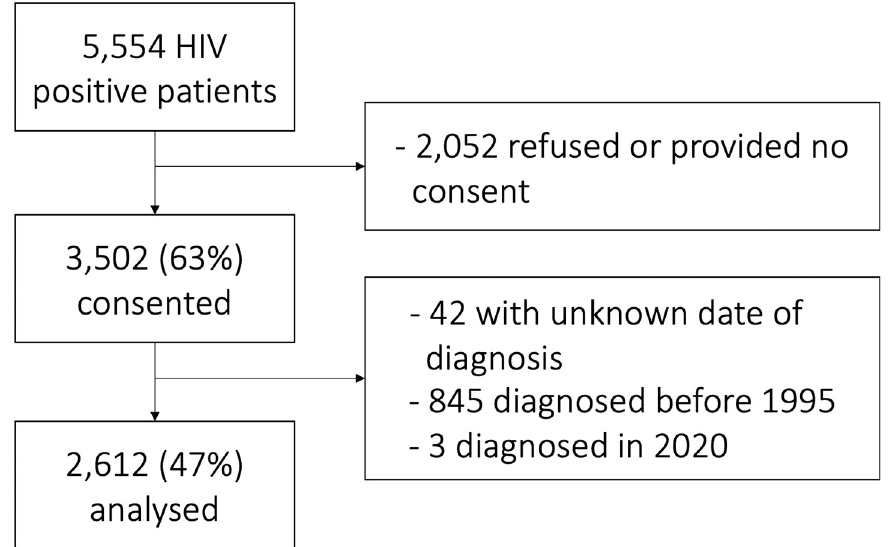
Fig 1. Flow diagram of participants to the HIV-positive cohort at the Clinique médicale l’Actuel in Montre´al, Canada.